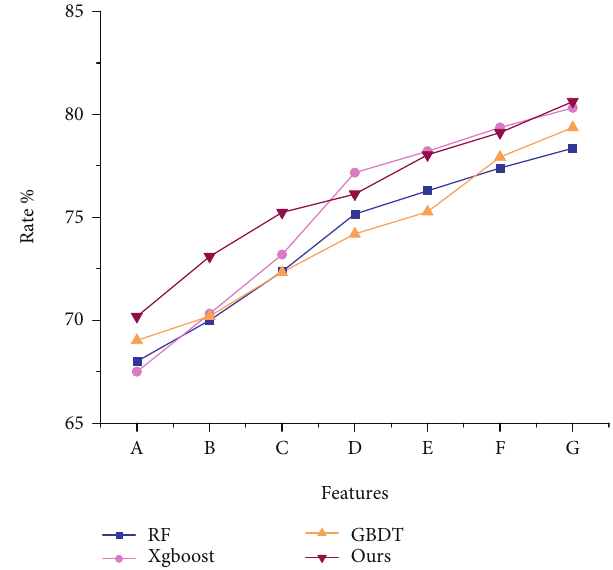
Figure 9: E ff ect curves of varying features on prediction